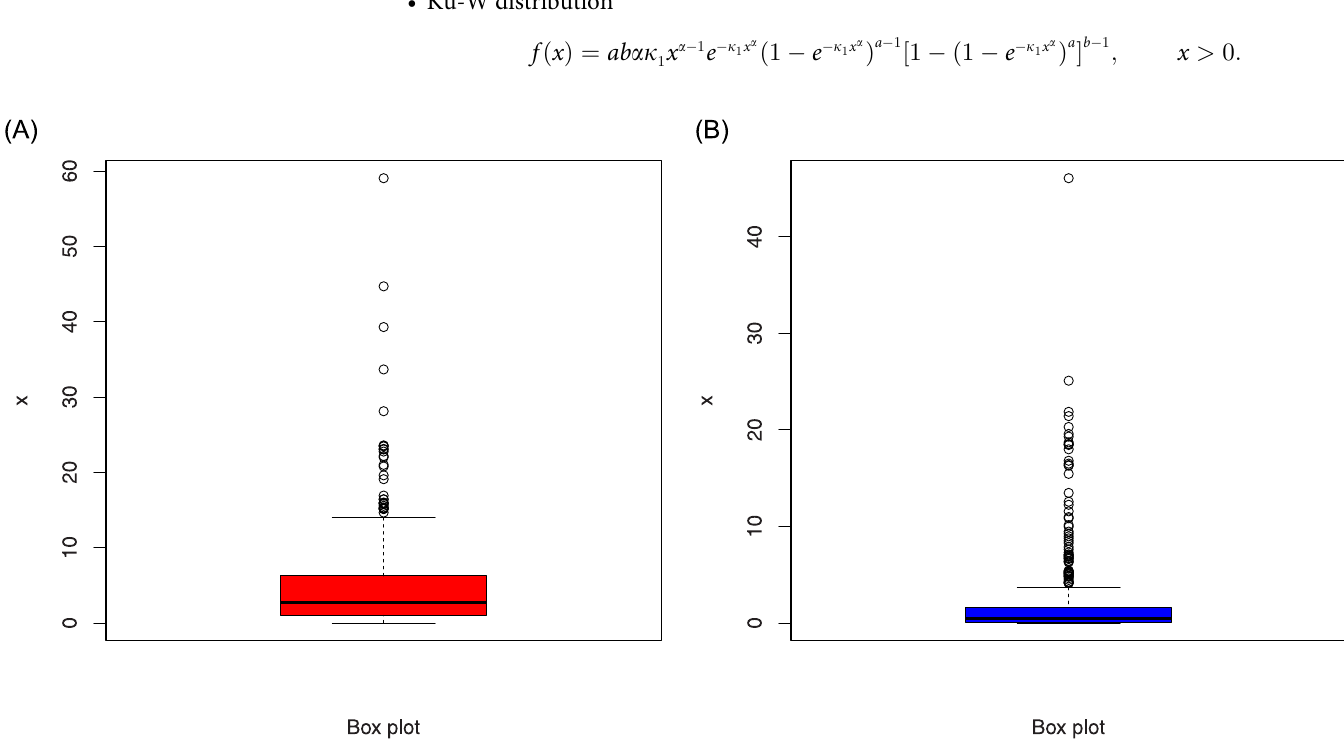
Fig 6. Box plots of the simulated data set 1 (red color) and set 2 (blue color).